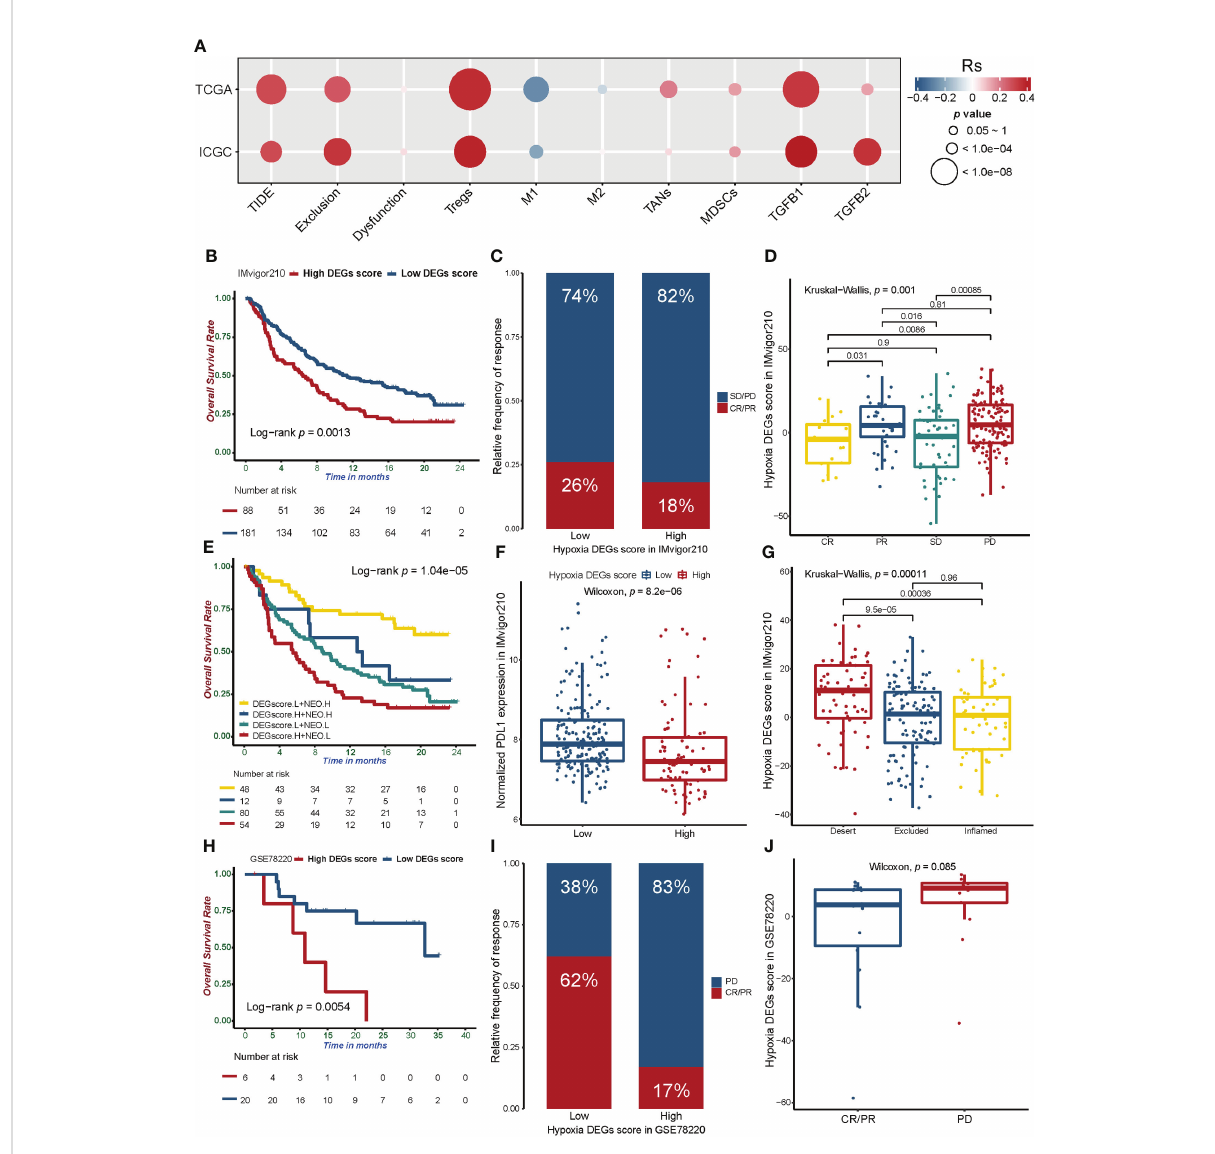
FIGURE 7 The relationship between the Hypoxia_DEGs_Score and ef fi cacy of immunotherapy. (A) Correlation of the Hypoxia_DEGs_Score with the TIDE score, in fi ltration of immunosuppressive cells, and expression of TGF- b . Rs is the coef fi cient of rank correlation. (B, H) Kaplan-Meier survival curves showing differences in overall survival between the high and low Hypoxia_DEGs_Score groups in the IMviogor210 (B) and GSE78220 (H) cohorts. (C, I) The proportion of patients in the IMvigor210 (C) and GSE78220 (I) cohorts with different PD-L1 and PD-1 blockade immunotherapy responses. (D, J) Difference in the Hypoxia_DEGs_Score between distinct clinical outcomes of anti-PD-L1 and PD-1 treatment in the IMvigor210 (D) and GSE78220 (J) cohorts. (E) Kaplan-Meier survival curves demonstrating distinctions in overall survival strati fi ed by both the Hypoxia_DEGs_Score and tumor neoantigen burden. (F) Differences in PD-L1 expression between low and high Hypoxia_DEGs_Score groups in the IMviogor210 cohort. (G) Differences in the Hypoxia_DEGs_Score among immune phenotypes, including the in fl amed (yellow), excluded (blue), and desert (red) immune types in the IMvigor210 cohort. CR, complete response; PR, partial response; SD, stable disease; PD, progressive disease; NEO, tumor neoantigen burden; L, low; H,